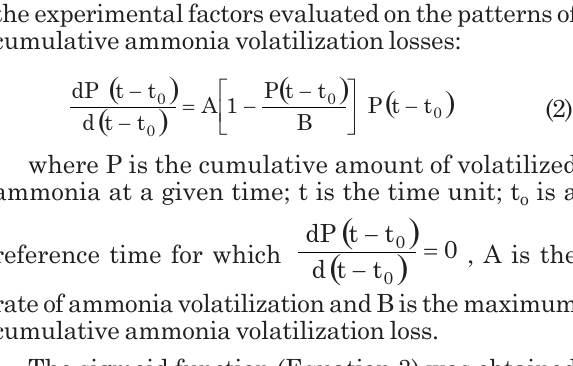
were moistened and left to rest. Immediately before the application, the soil samples were blended and subsamples were taken for moisture determination.